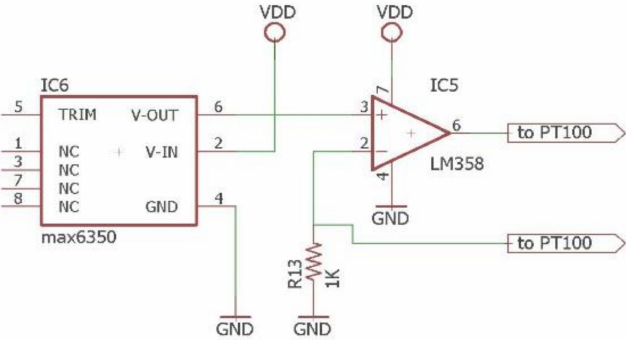
Figure 7. Constant-current source employed to enable the four-wire measurement of the PT100